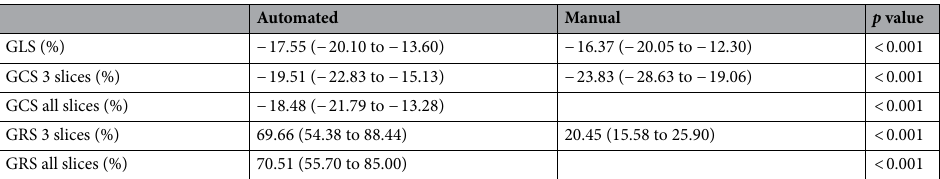
Table 2. Strain measurements for manual and automated strain; GLS, GCS and GCS all slices, GRS and GRS all slices. Strain measurements are continuous variables represented by median and interquartile range. Wilcoxon signed rank test was used to calculate the p value for manual values and their respective automated values. Automated GCS and GRS all slices were compared to the manual method of obtaining the average of 3 slices. GCS, global circumferential strain; GLS, global longitudinal strain; GRS, global radial strain.